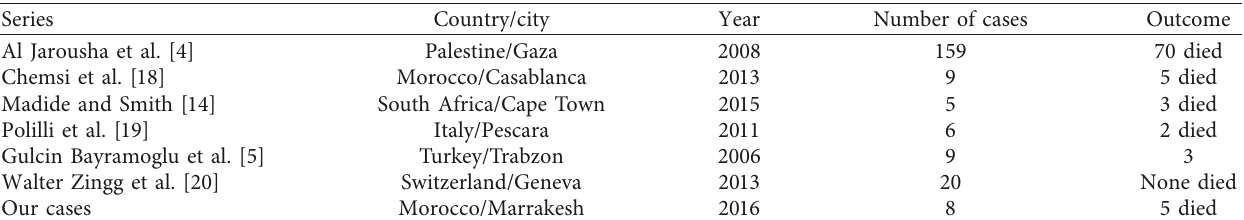
Table 3: Summary of outbreaks caused by S. marcescens reported in the literature in comparison with our experience. Series Country/city